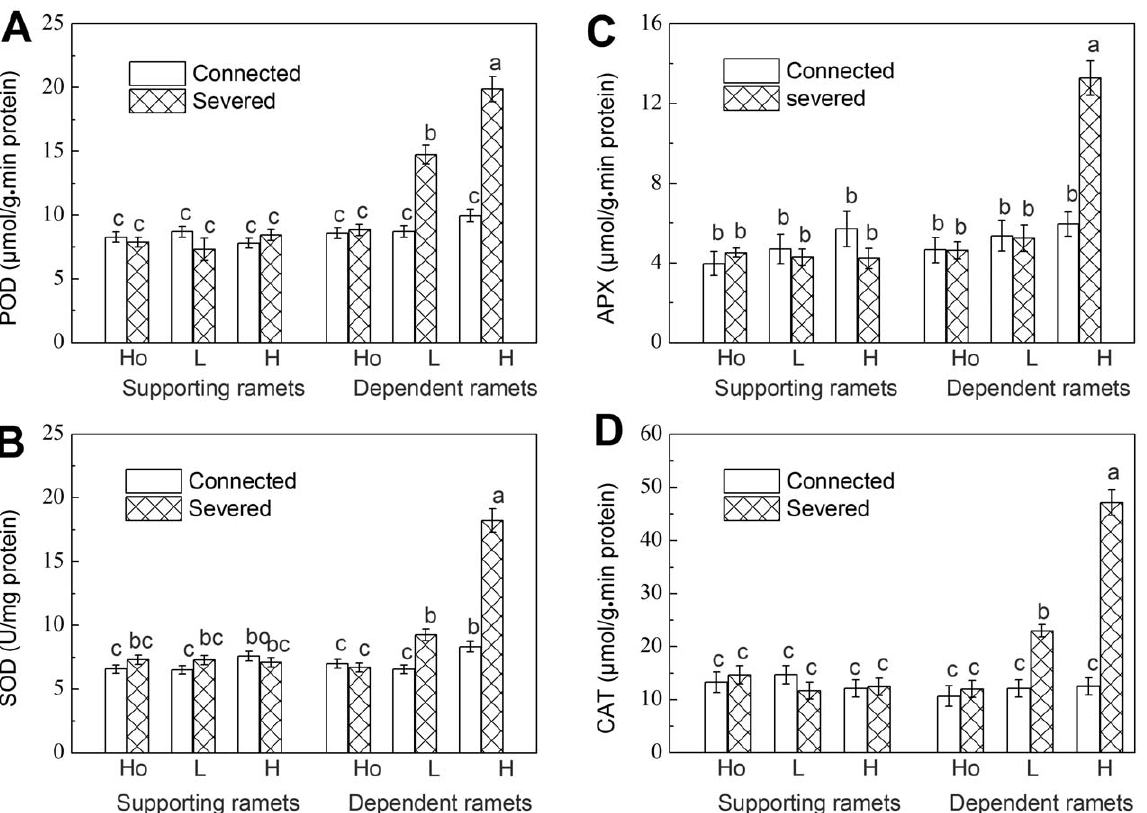
Figure 3. Antioxidant enzymes activity. (A) POD, (B) SOD, (C) APX and (D) CAT of the supporting and the dependent ramets. Data are means 6 SE (n=15). Bars sharing the same lowercase letter are not different at p=0.05. Treatments are coded as in Table 1.